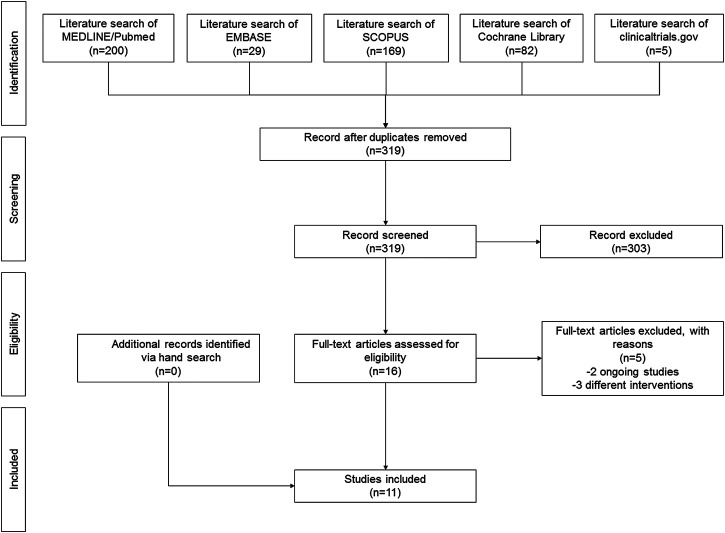
PRISMA flow diagram.